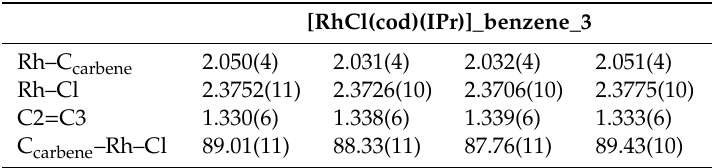
Table 2. The most important bond lengths (Å) angles ( ◦ ) of the four individual molecules in the unit cells of the benzene solvate of 3 , i.e., [RhCl(cod)(IPr)]_benzene_ 3 .